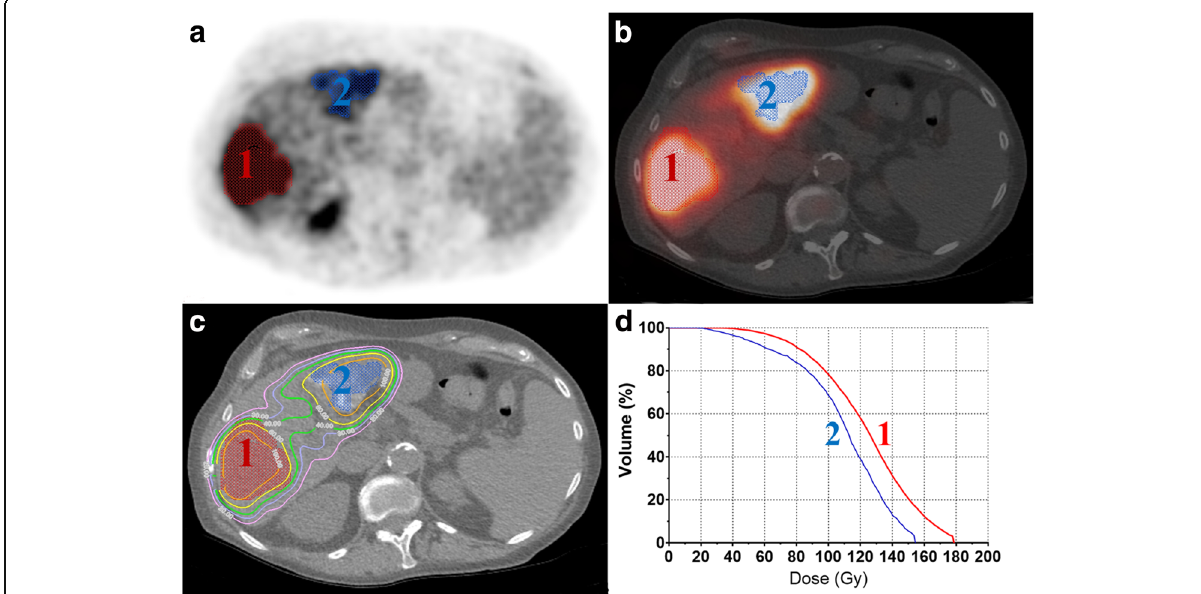
Fig. 1 Post-treatment dosimetry process. a Baseline FDG-PET shows the delineated lesions (1 and 2). b Axial 90 Y-PET/CT image on which two target lesion volumes have been projected, showing a high 90 Y-microsphere uptake. c 90 Y-microsphere-absorbed dose map showing that the lesions receive high absorbed doses ( D mean -1 = 124 Gy and D mean -2 = 109 Gy). d Dose volume histograms of the two lesions (1 and